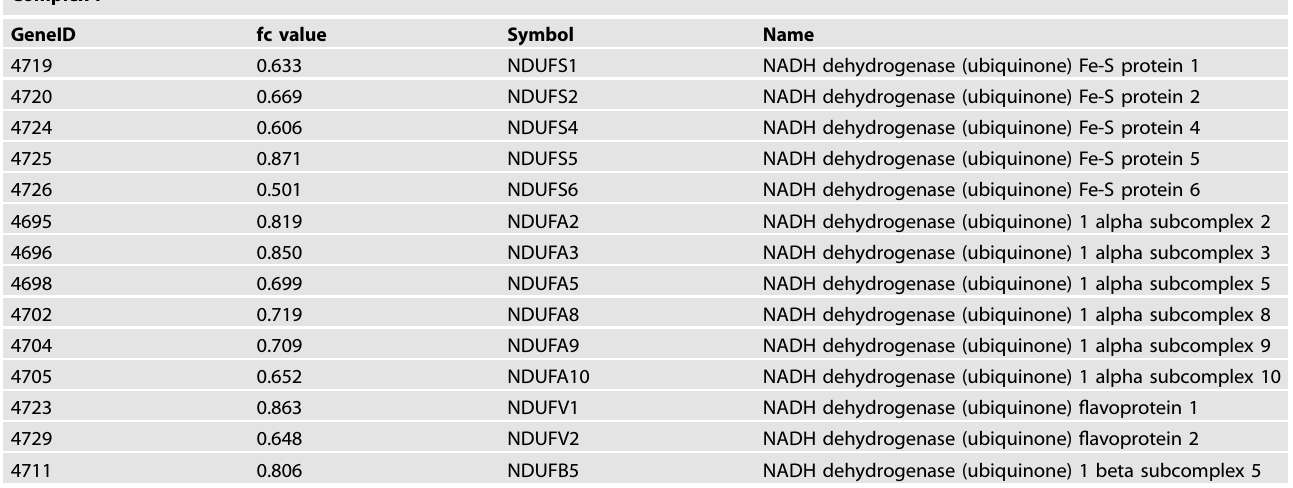
Table 1. Identi fi cation of downregulated genes of complex I in H1299 ρ 0 and ρ + cells. Complex